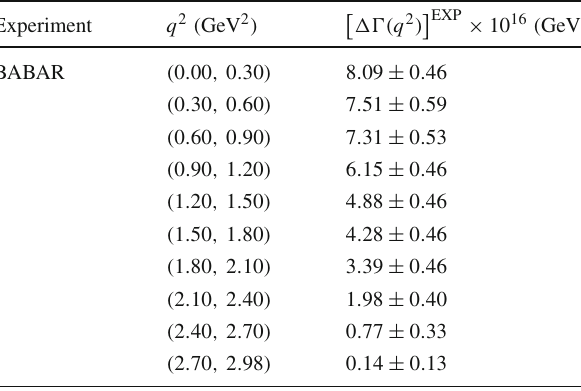
Table 2 Values of the partial decay rates transition in the q 2 -bins measured by BABAR [6] Experiment q 2 ( GeV 2 ) BABAR